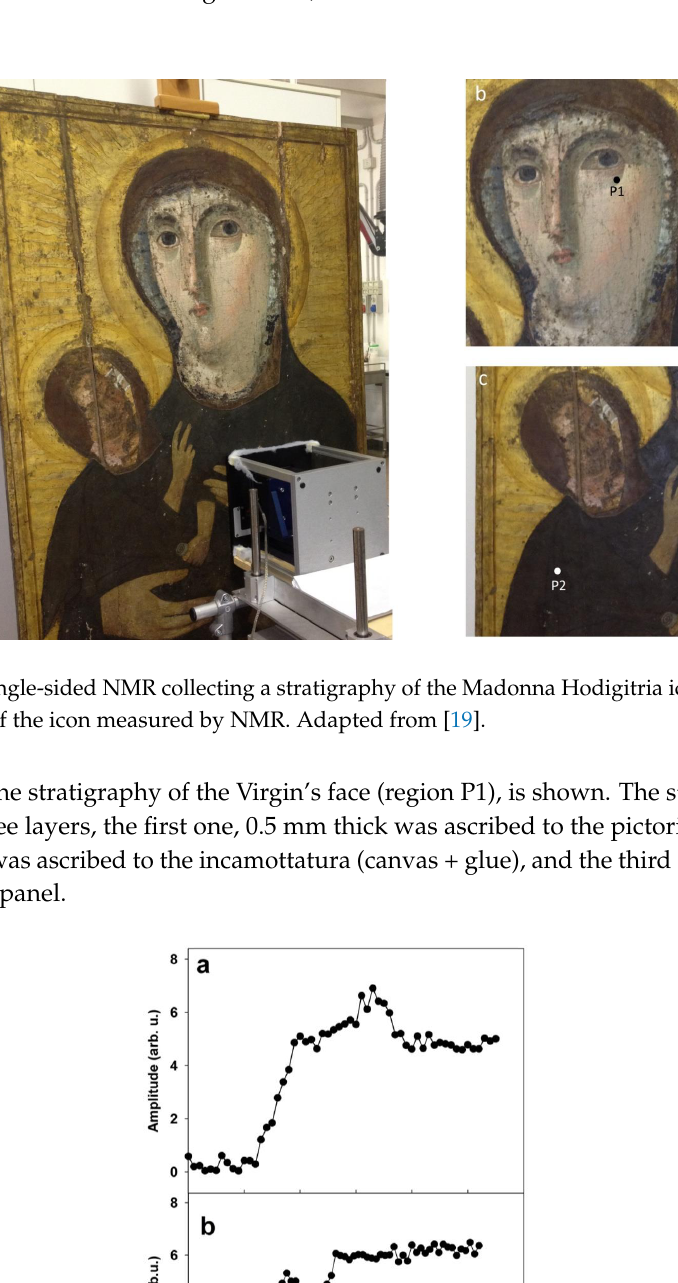
Figure 12. 1 H NMR stratigraphy of ( a ) region P1 (Virgin’s face), and ( b ) region P2 (Virgin’s mantle). Adapted from [19].